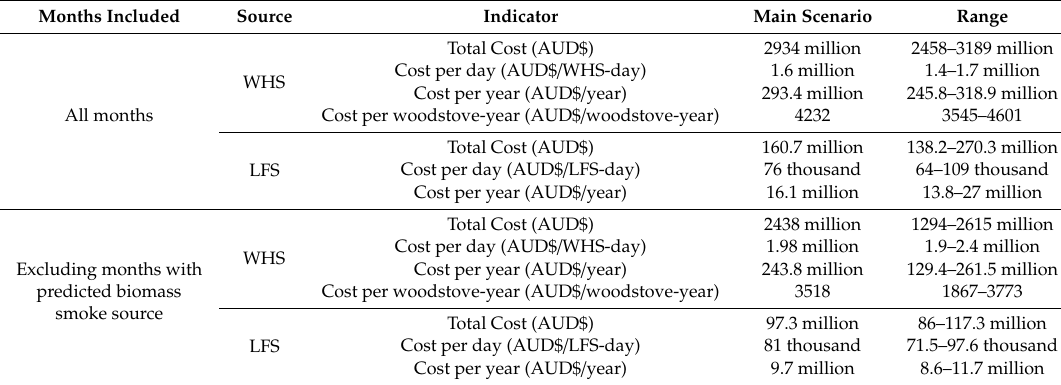
Table 8. Health economic indicator ranges from sensitivity